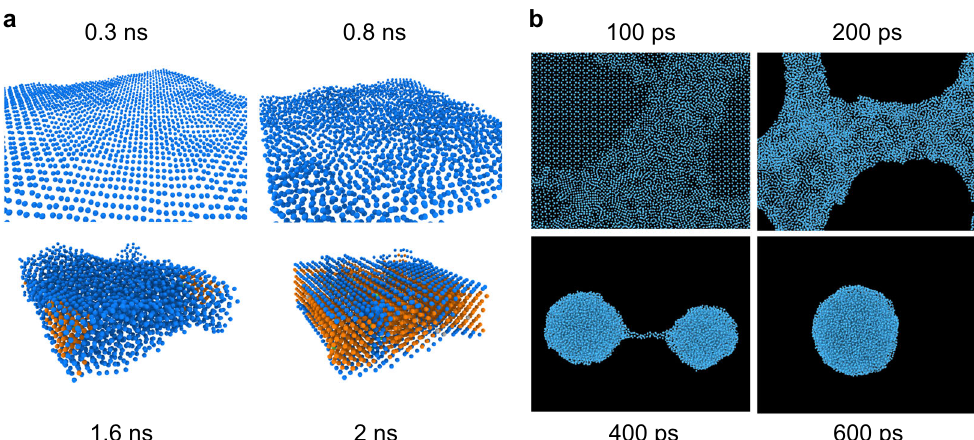
Fig. 4 Large-scale molecular dynamics simulation of the inter-dimensional transformation of stanene. a The monolayer – bulk transition at ~200 K. Using common neighbor analysis, the orange atoms are identi fi ed as bcc sites, and atoms of other colors are identi fi ed as other sites.